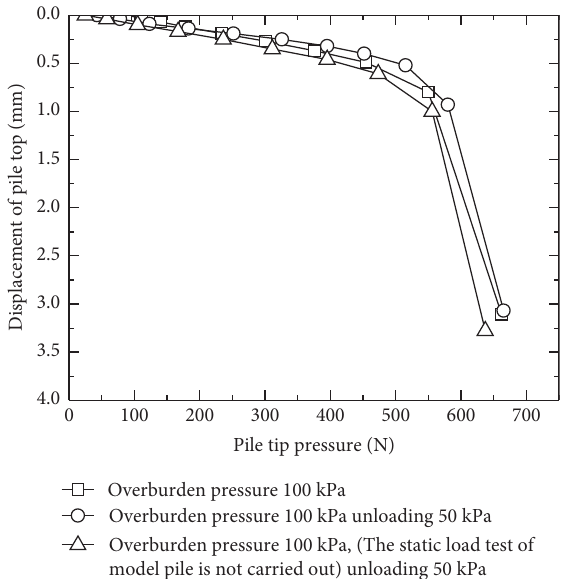
Figure 17: Pile top load versus pile top displacement.